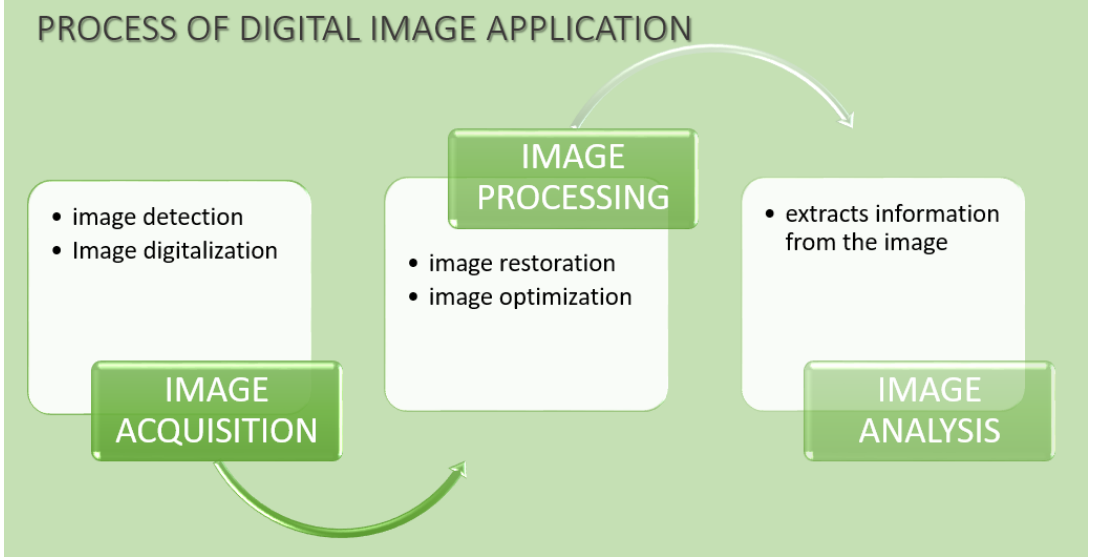
Figure 10. Steps in digital image analysis.